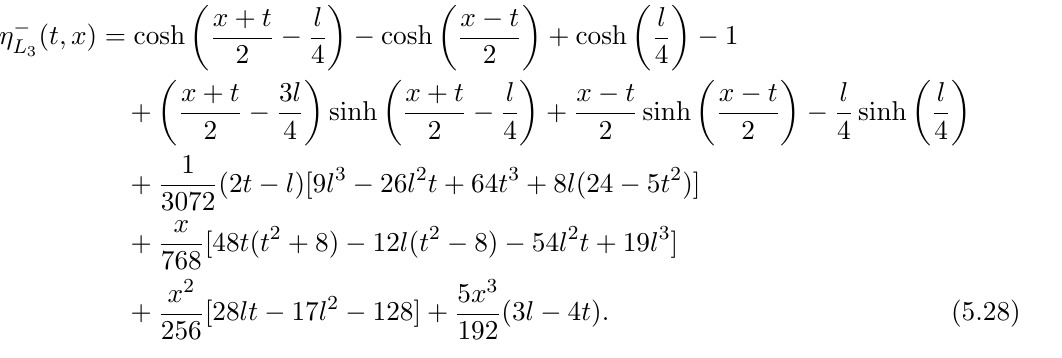
( t; x ) has to satisfy the boundary conditions (cid:17) (cid:0) L 3